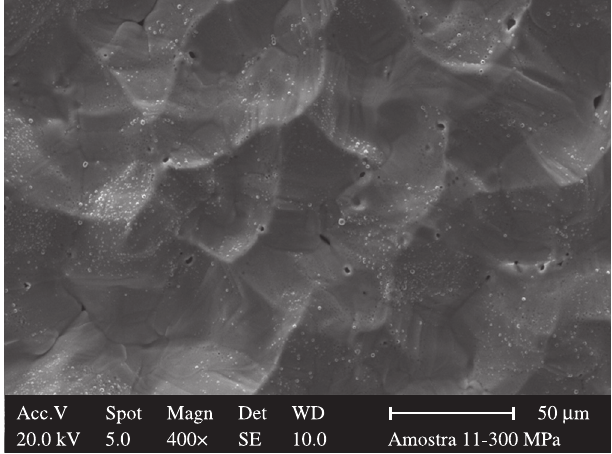
Figure 9. Electronic micrograph of the surface of a sample sintered on the cathode.